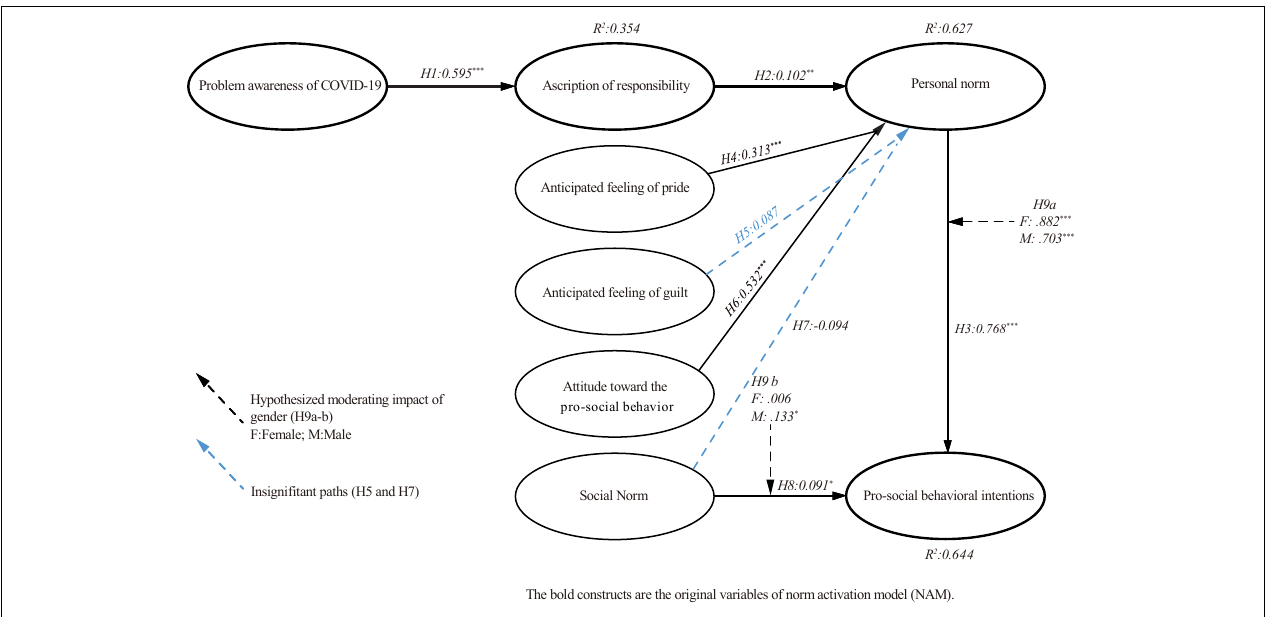
FIGURE 4 | Results of the structural equation